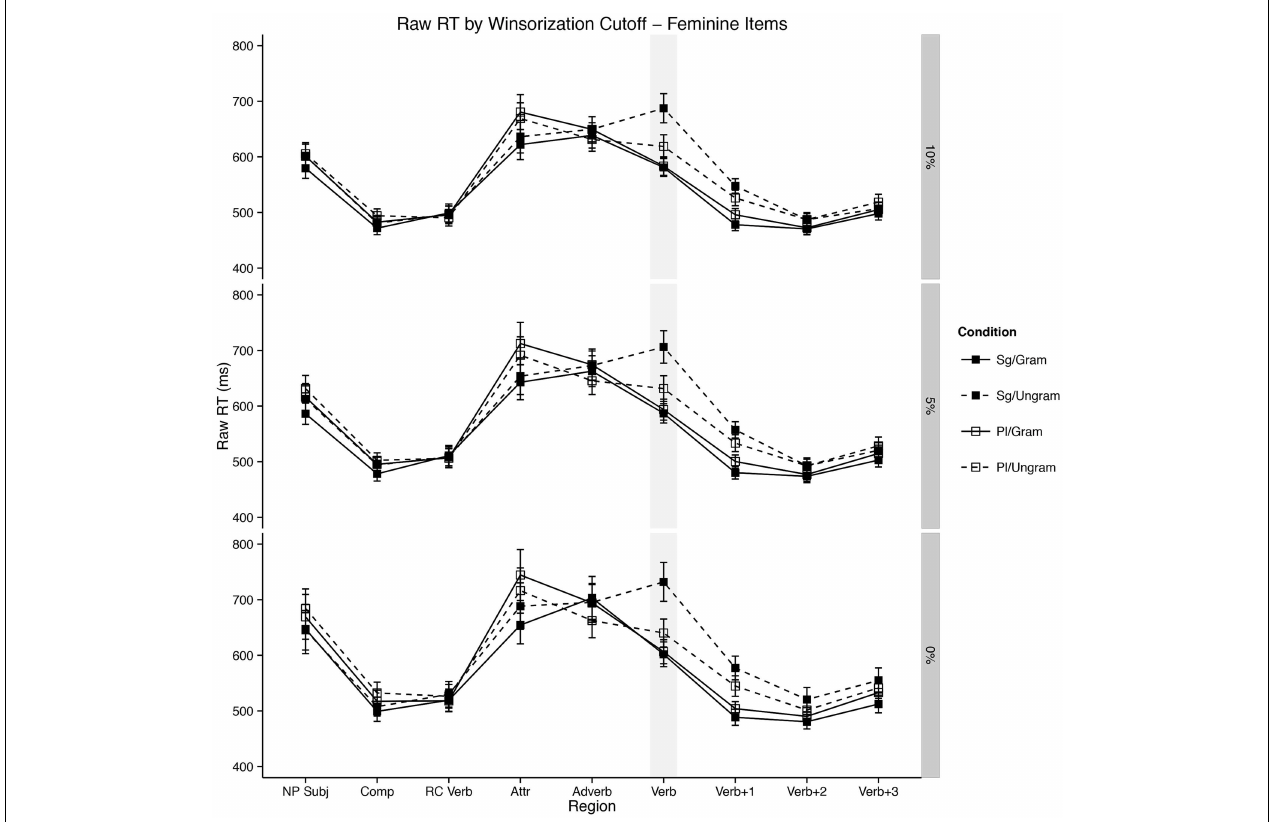
FIGURE 3 | Self-paced reading results. Region by region means of feminine items segregated by attractor number and verb number for three Winsorization cutoff thresholds. Error bars represent the standard error of the mean computed across subject